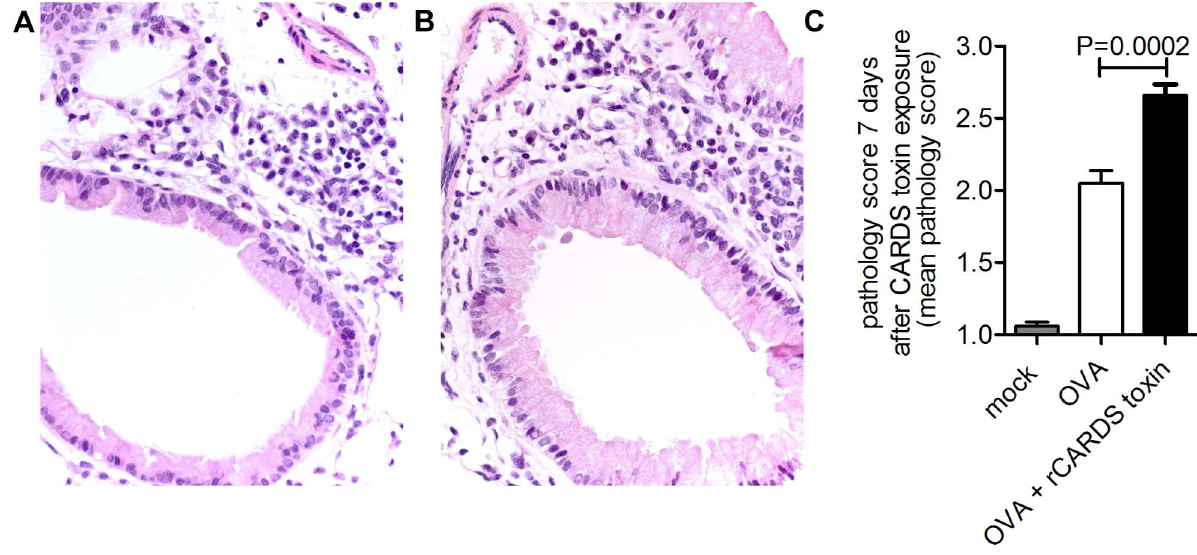
Figure 1. rCARDS toxin exacerbates inflammation associated with OVA treatment. A-B) H&E stained lung sections demonstrating inflammation in OVA (panel A) or OVA + rCARDS toxin (panel B) 40x magnification. C) Quantification of average histological scores from OVA or OVA + rCARDS toxin mice on day 7 (p=0.0002).